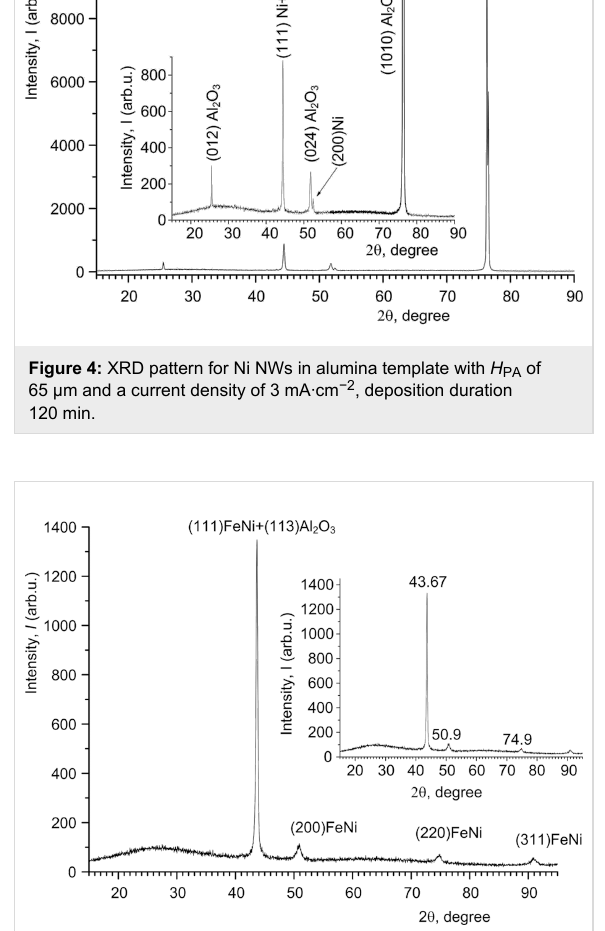
vertically along a pore). The existence of other weak peaks shows the presence of small amount of crystallites with other directions of growth and confirms the polycrystalline structure of Ni